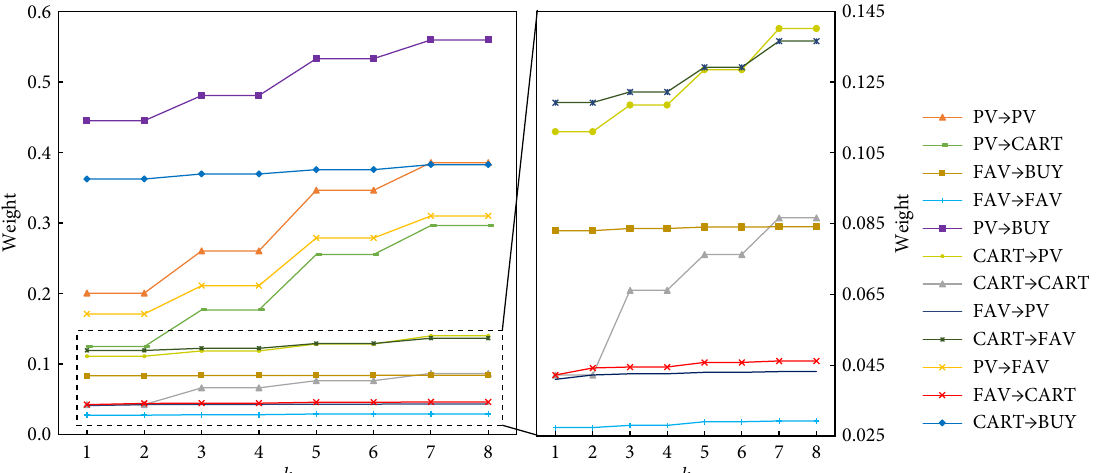
Fig. 7 Experimental result on the EComm dataset. The weights of links that start with BUY are too small; thus, they are hidden in this figure. The figure on the right is a partial enlargement of the figure on the left.